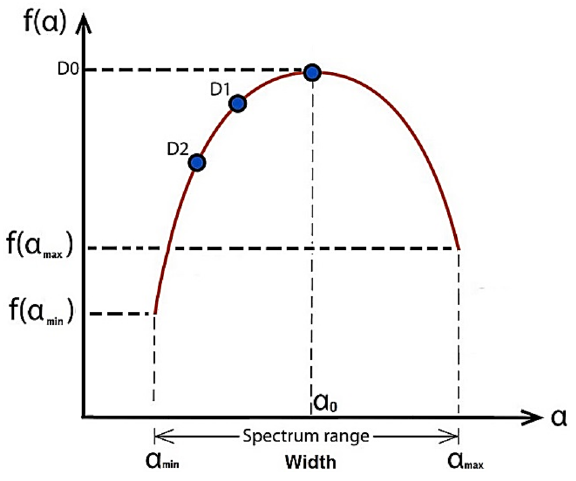
Figure 6. The extracted